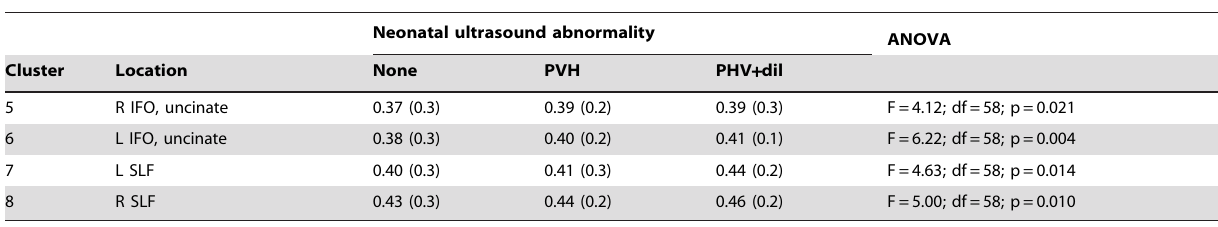
Table 4. FA in relation to severity of neonatal brain injury in the VPT group.